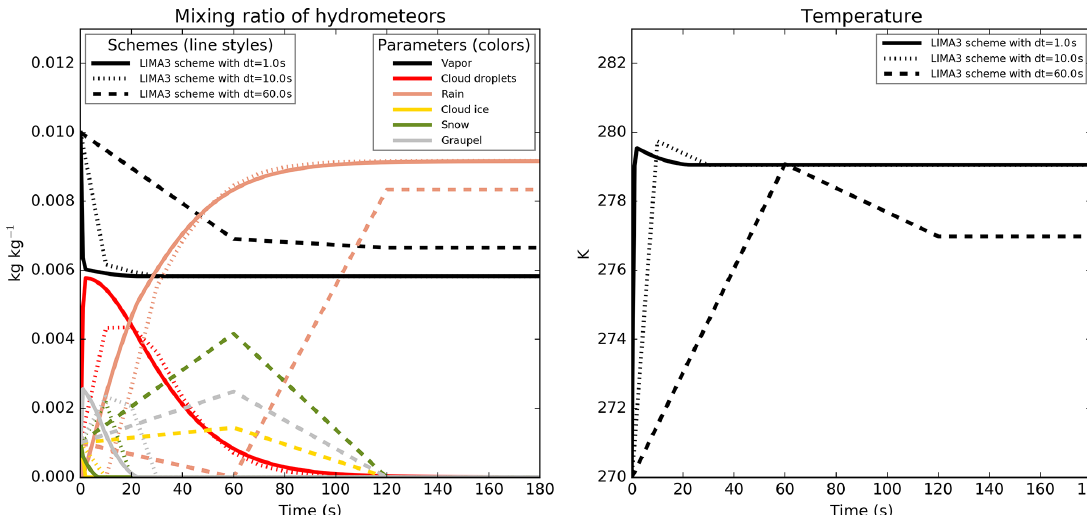
Figure 2. Same as Fig. 1 but using the LIMA scheme.